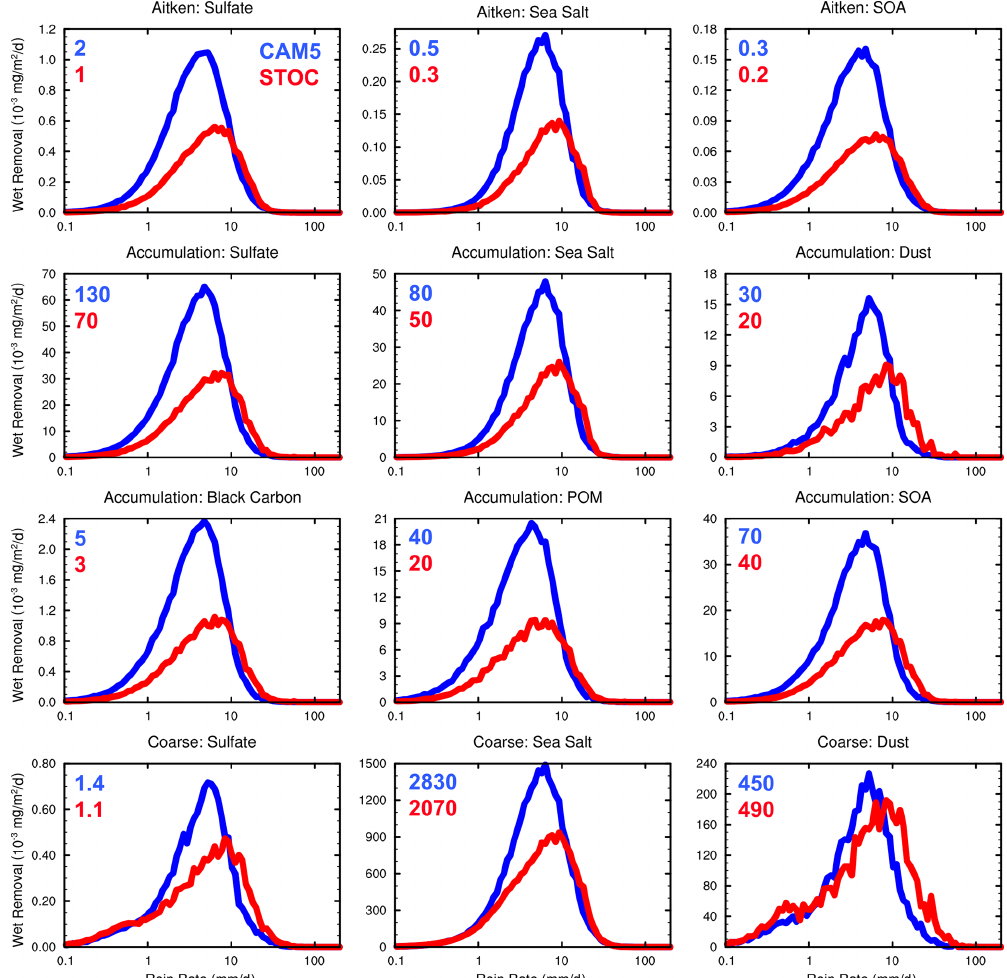
Figure 6. Same as Fig. 4, but over 50, 90 ◦